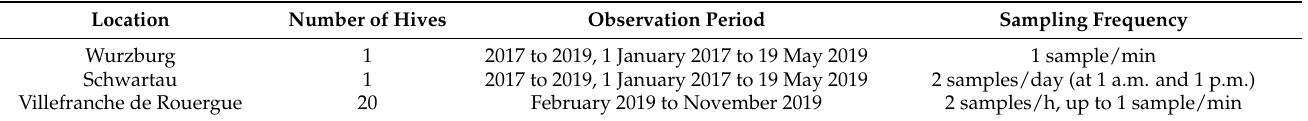
Table 1. Weight data measurement